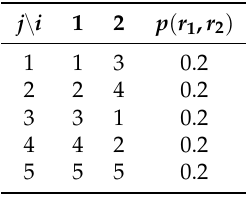
in Example r 1 , r 2 p q